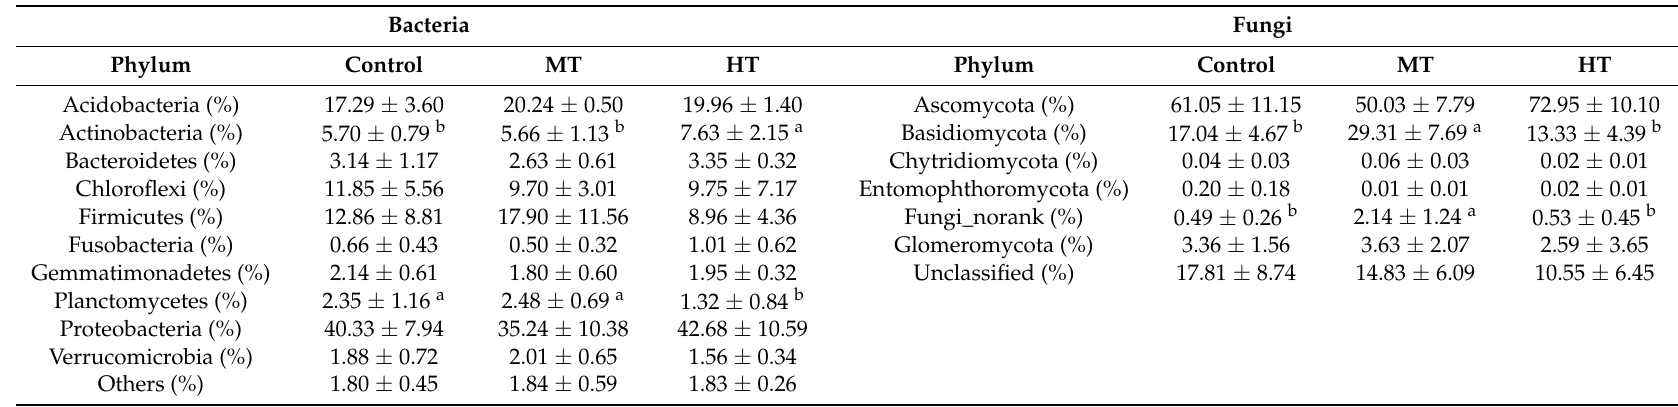
Table 4. Relative abundance of bacterial (relative abundances ≥ 1%) and fungal communities at the phylum level; Control: conventional management model, MT = moderate thinning, and HT = heavy thinning; n = 3, mean ± SD. Different lowercase letters above bars indicate significant differences among the three treatments ( p <